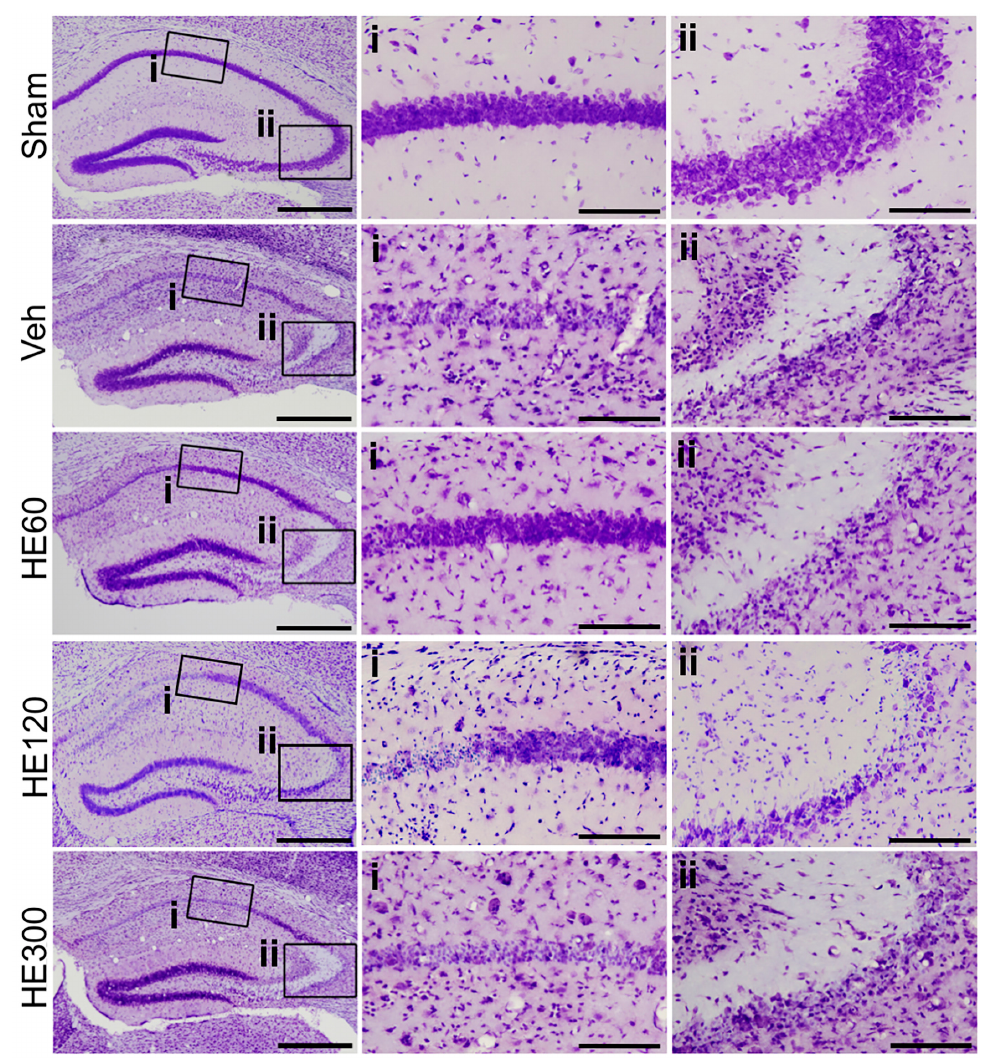
Figure 1. Hericium erinaceus (HE) administration at 60 mg/kg and 120 mg/kg decreased hippocampal cell deaths after pilocarpine-induced status epilepticus. Brain sections were stained with cresyl violet. ( i ) Magnified photomicrographs of CA1 subfield of the hippocampus, marked with a rectangle in the left picture. ( ii ) Magnified photomicrographs of CA3 subfield of the hippocampus, marked with a rectangle in the far-left picture. Note that vehicle (Veh)-treated animals showed extensive cell death in the CA1 and CA3 subfields of the hippocampus, compared to sham. HE treatment at 60 and 120 mg/kg could prevent cell death in CA1 but not CA3 subfield of the hippocampus, whereas 300 mg/kg of HE administration showed similar cell death with the group treated with vehicle. Scale bars in the left column: 500 μ m, scale bars in the middle column: 100 μ m, scale bars in the right column: 100 μ m.